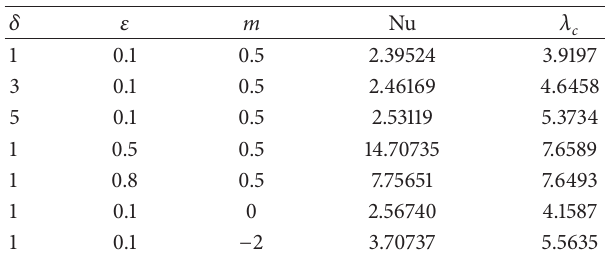
Table 1: Numerical values showing the effects of 𝛿 , 𝜀 , and 𝑚 on thermal criticality